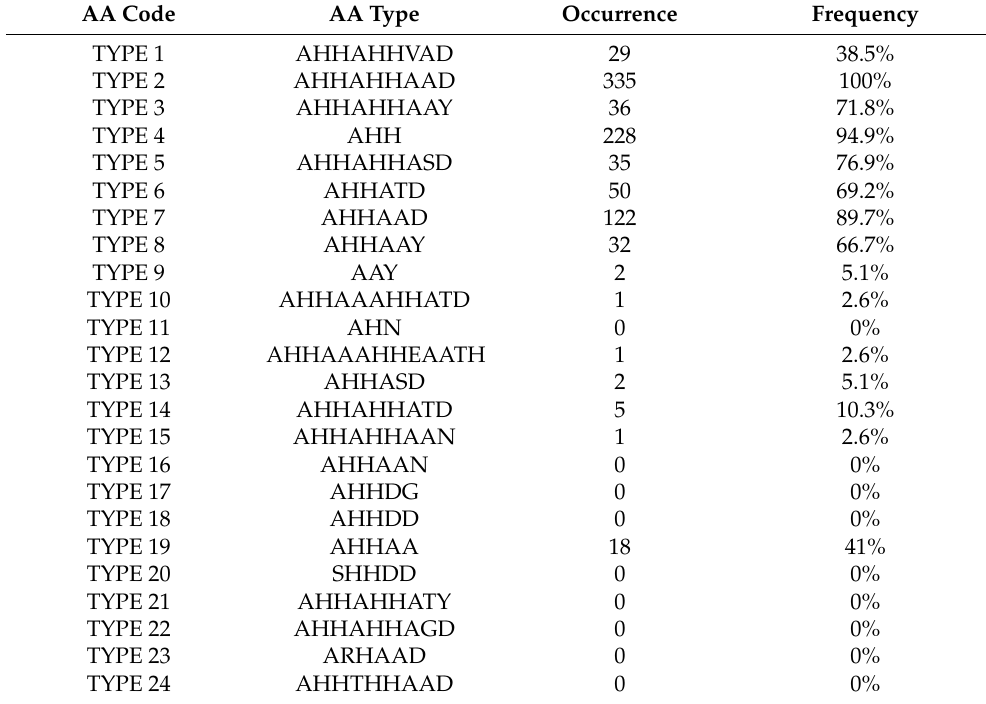
Table 1. Prevalence and occurrence of different amino acid repeats observed in P. falciparum HRP2 from field isolates in north-eastern